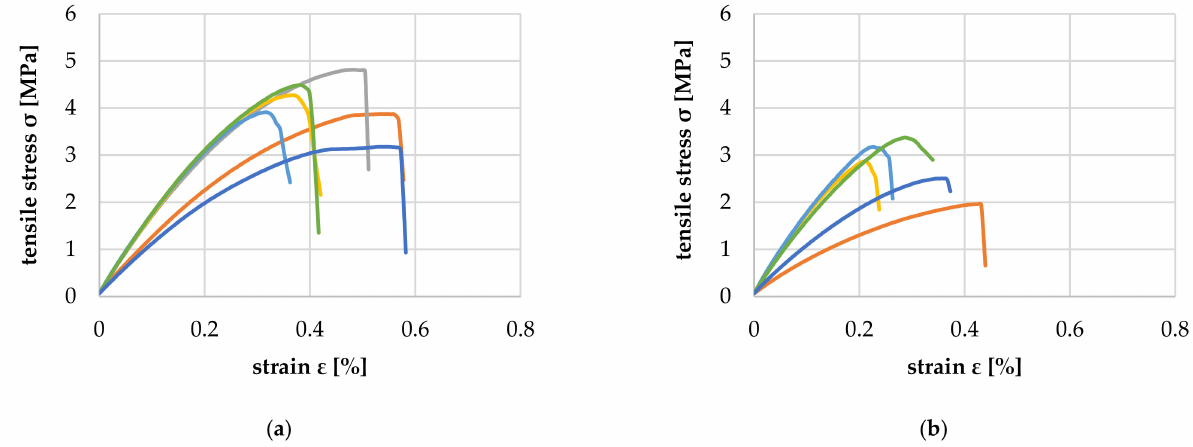
Figure 24. Transverse tensile properties of PP-based WPC with 80 ( a ) and 90 wt% ( b ) wood